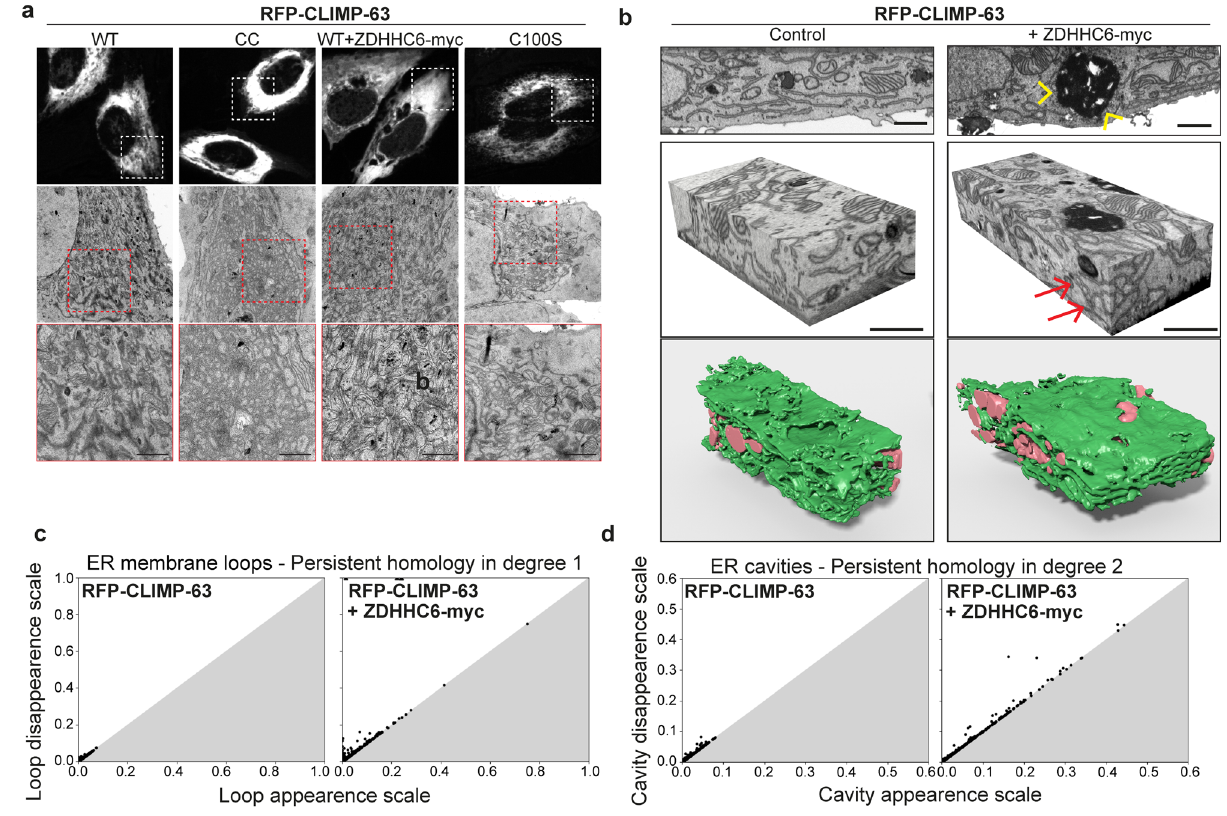
Fig.7|UltrastructureanalysisofERmorphology.a Correlatedlightandelectron microscopy of shCLIMP-63 HeLa cells overexpressing RFP-CLIMP-63 WT, CC or C100S,orRFP-CLIMP-63WTtogetherwithZDHHC6-myc.Lightmicroscopyimages (top)withtheboxedregion(red)indicatingtheareaimagedwithTEM(middle)and zoomedregion(bottom)(second red box).Scale bars: 1 μ m. b FIBSEM wasused to 3D image the ER in RFP-CLIMP-63 in control or upon overexpression of ZDHHC6 (detected by the presence of OSERs — yellow arrowheads). FIBSEM image stacks